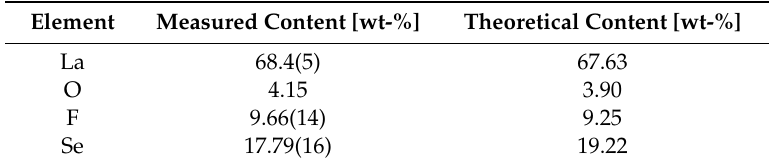
Table 7. Results of an energy-dispersive X-ray spectrometer (EDXS) measurement on a single crystal of B-type La 2 OF 2 Se.